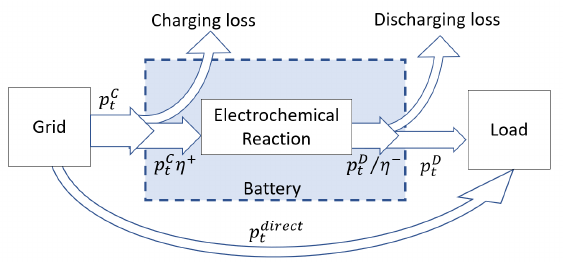
Figure 1. Schematic representation of energy fluxes from the grid to the load. The load can consume energy directly from the grid or from a previously charged battery. p t represents the power at time t (superscripts C and D denote charge and discharge processes); η + , η − represent battery